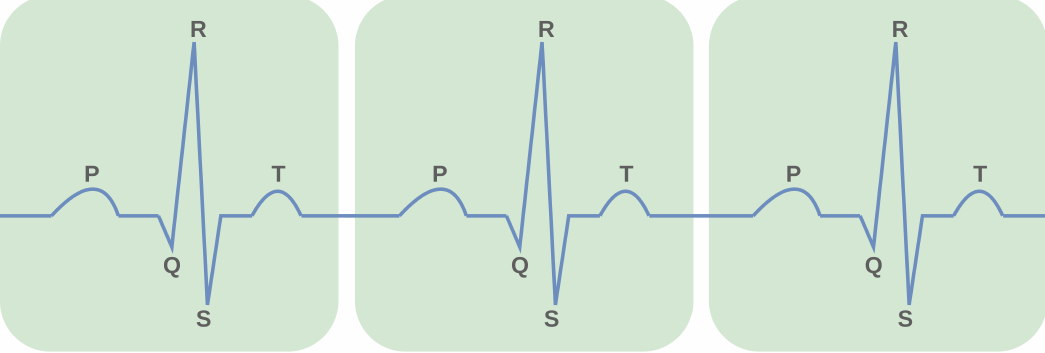
Figure 5. PQRST wave